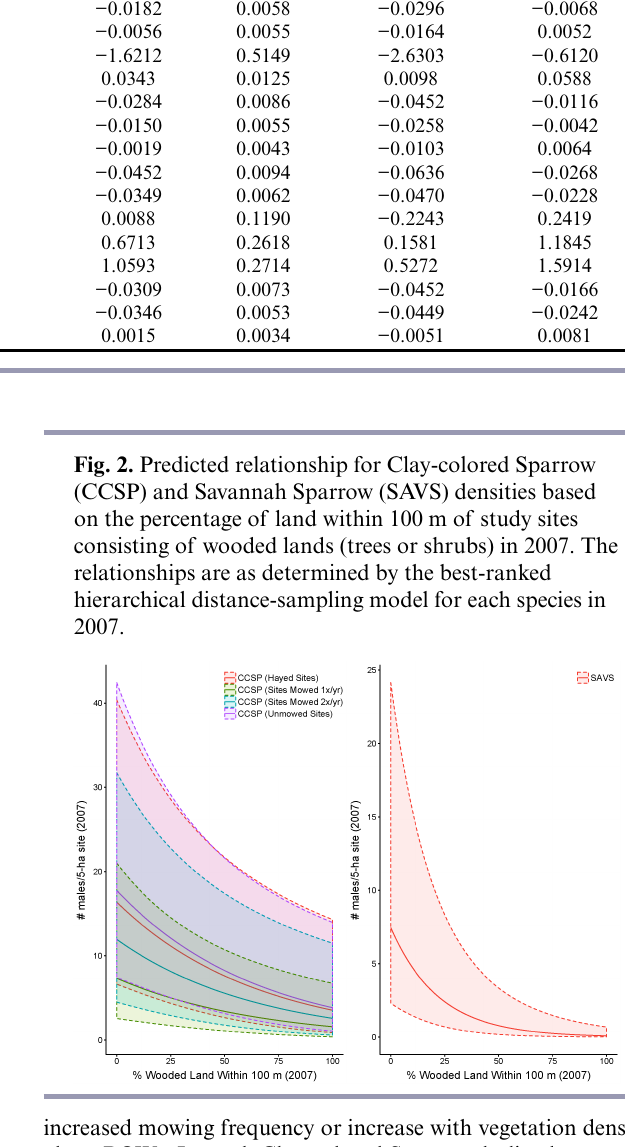
increased mowing frequency or increase with vegetation density along ROWs. Instead, Clay-colored Sparrow declined as woody plant cover increased and increased as litter cover increased (Table 1; Appendix 2, Table A2.D). In 2009, a model containing just land use effects (urban land + wooded land + grassland) was more parsimonious than other top models (Table 1; Appendix 2, Tables